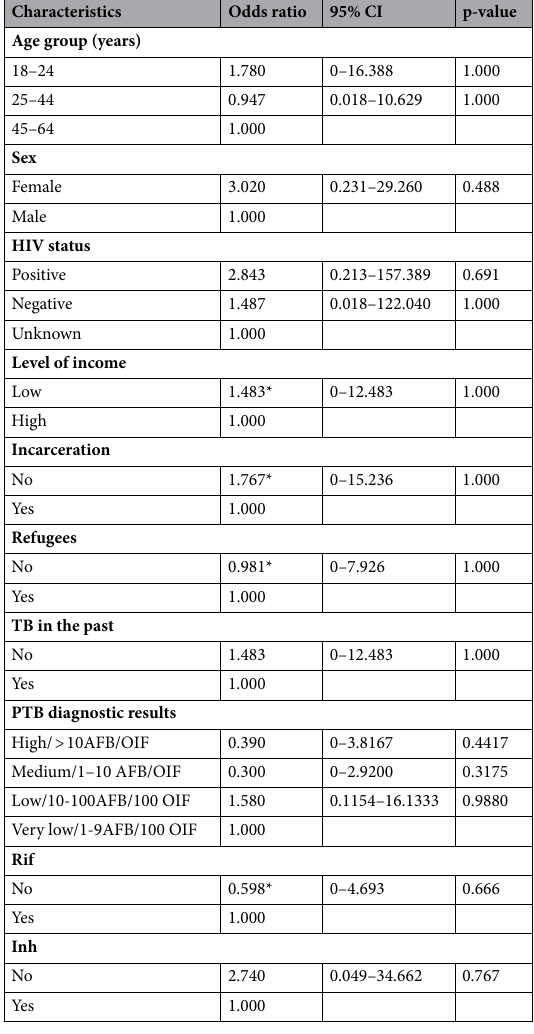
Table 4. Exact bivariate logistic regression of factors associated with multiple strains of M. tuberculosis infections among PTB patients in Southwestern, Uganda. *Median unbiased estimates (MUE); OIF oil immersion field, Rif Rifampicin, Inh